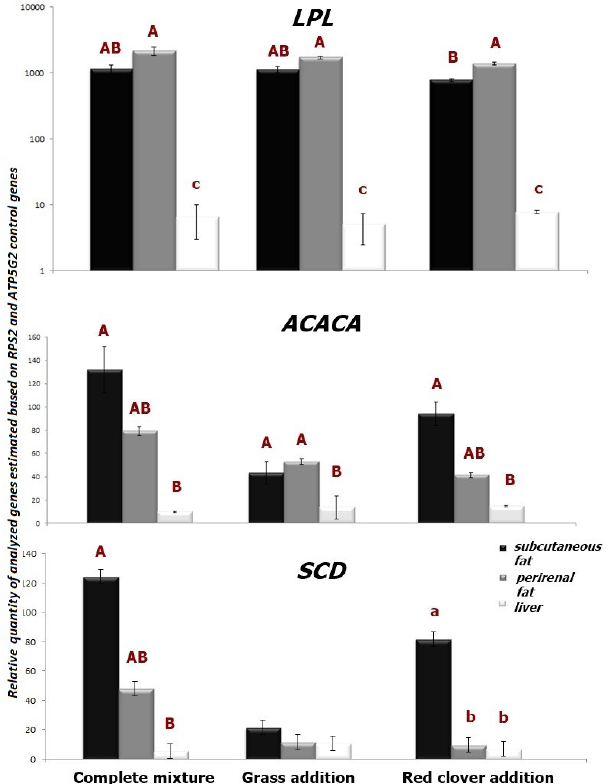
Figure 2. The differences in expression of LPL , ACACA and SCD genes between analyzed ovine tissues regardless of feeding supple- mentation. Data are presented as mean ± standard error; means with a,b and A,B differ significantly at P <0.05 and P <0.01, respec-